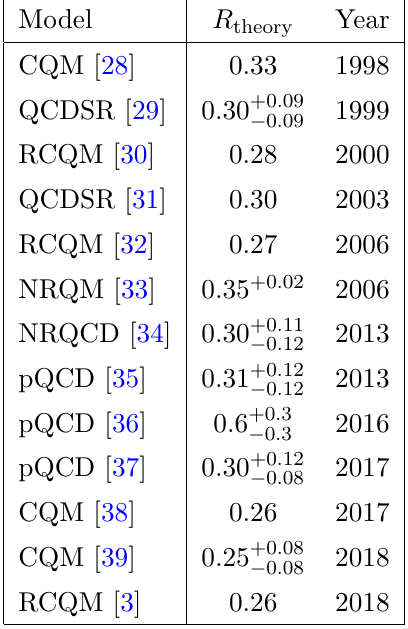
Model predictions of R ( (cid:17) c ) classi(cid:12)ed by method, which are abbreviated as: con- stituent quark model (CQM), relativistic quark model (RCQM), QCD sum rules (QCDSR), non- relativistic quark model (NRQM), nonrelativistic QCD (NRQCD), and perturbative QCD calcula- tions